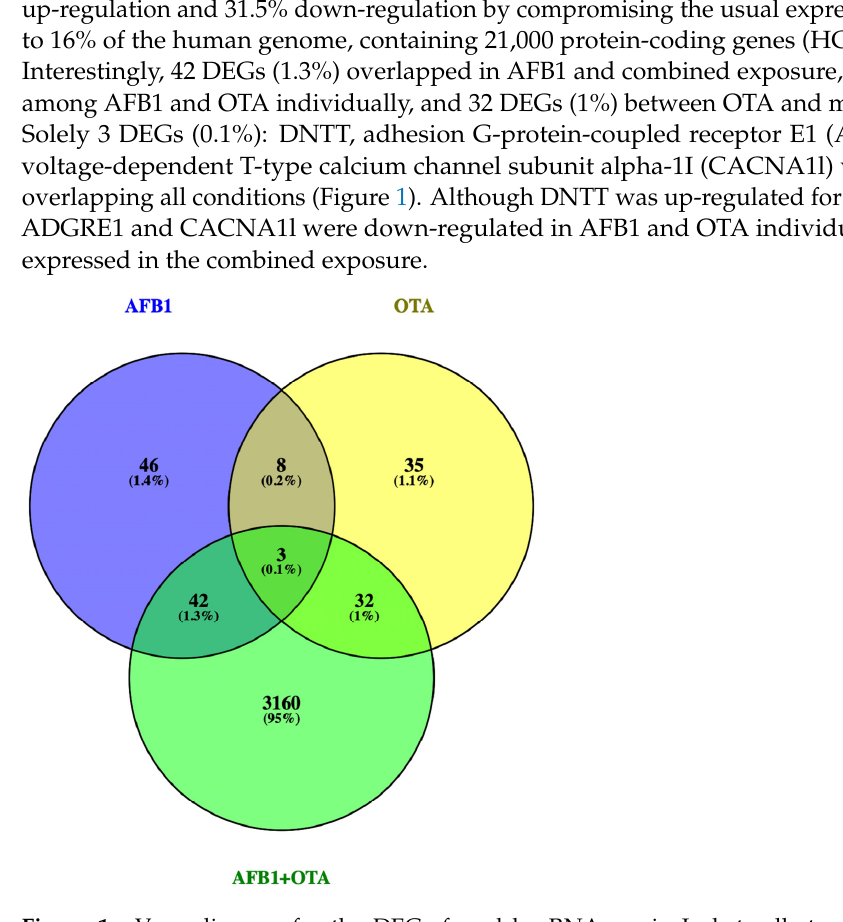
Figure 1. Venn diagram for the DEGs found by RNA-seq in Jurkat cells treated with AFB1, OTA, AFB1 + OTA at 100 nM in 0.1% DMSO compared to 0.1% DMSO control exposure. DEGs p -value ≤ 0.05 and log2FC |0.5|.